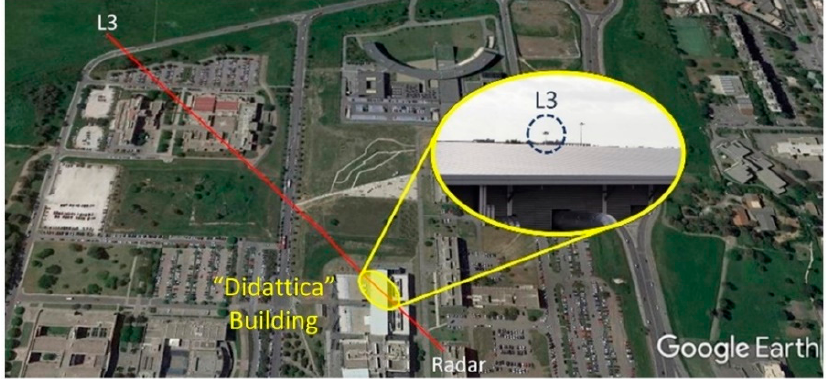
Figure 12. Reflection point on the ground for L3.